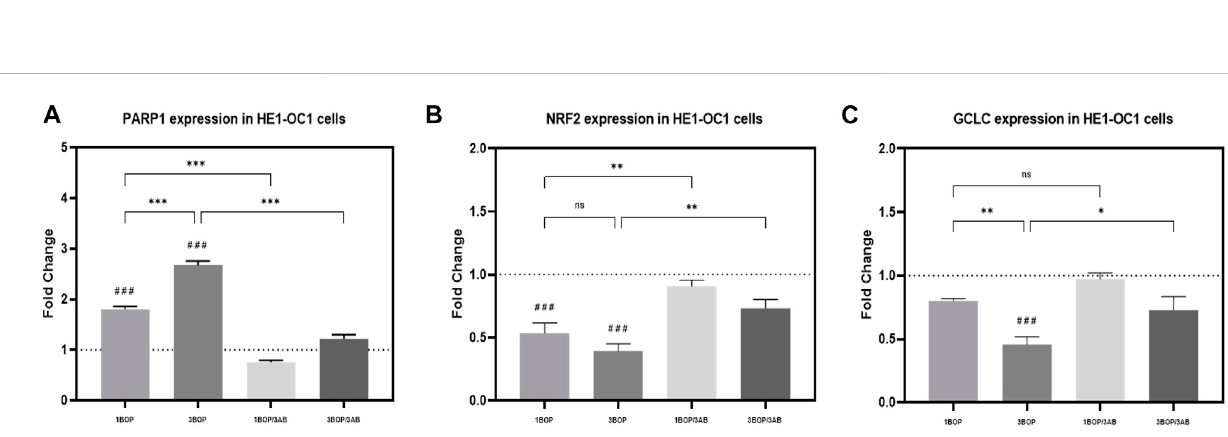
Effect of BOP on the cellular ATP levels of HEI-OC1 cells after blast overpressure using Seahorse XF 24 Analyzer. The histogram shows the (A) TotalATP, (B) mitoATP & (C) GlycoATP in HEI-OC1 cells following BOP/3AB treatment (3 mM). * p < 0.05; ### p < 0.001 versus sham. Values are represented as Mean ± SEM ( n = 3).